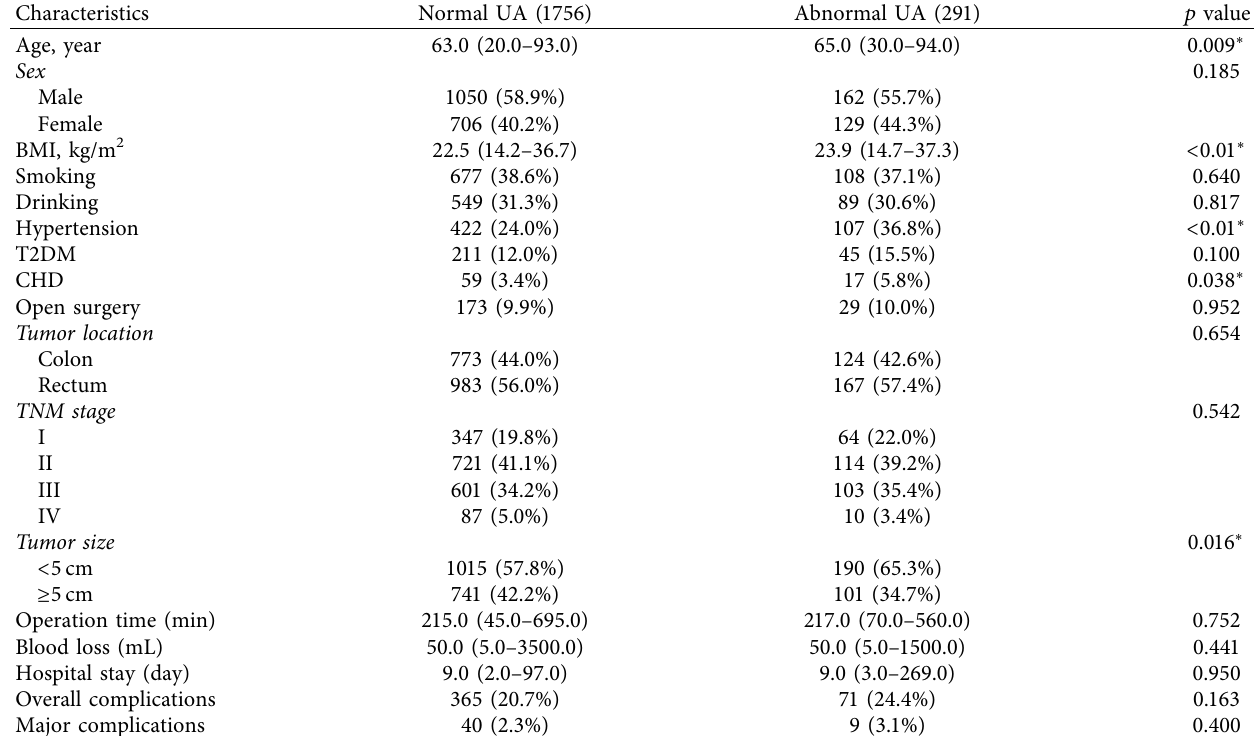
Table 2: Comparison between the normal UA group and the abnormal UA group.